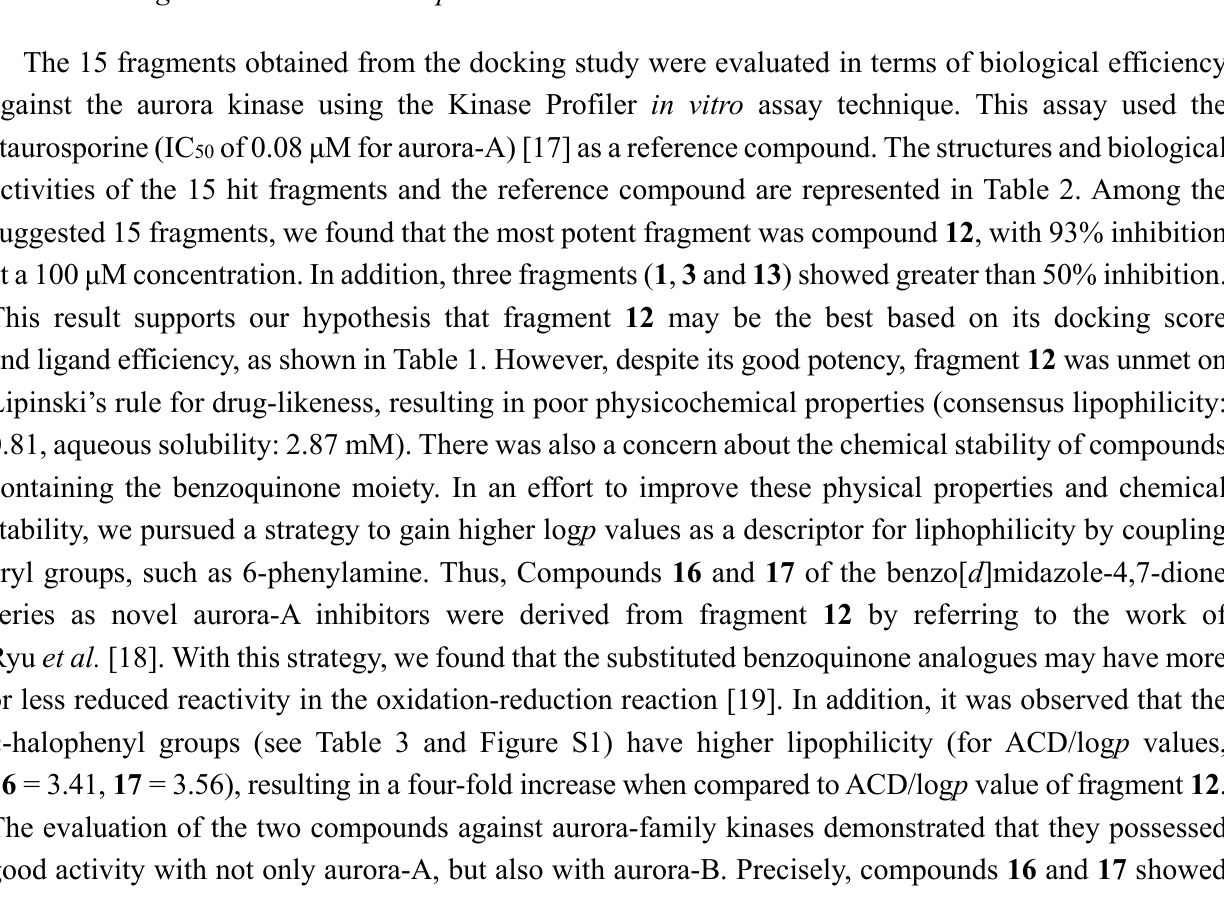
a Represented protein as a PDB code; b Ligand Efficiency (LE) = Mean of Dock Score / Non-hydrogen atoms of the fragments; and c A fragment does not bind to a